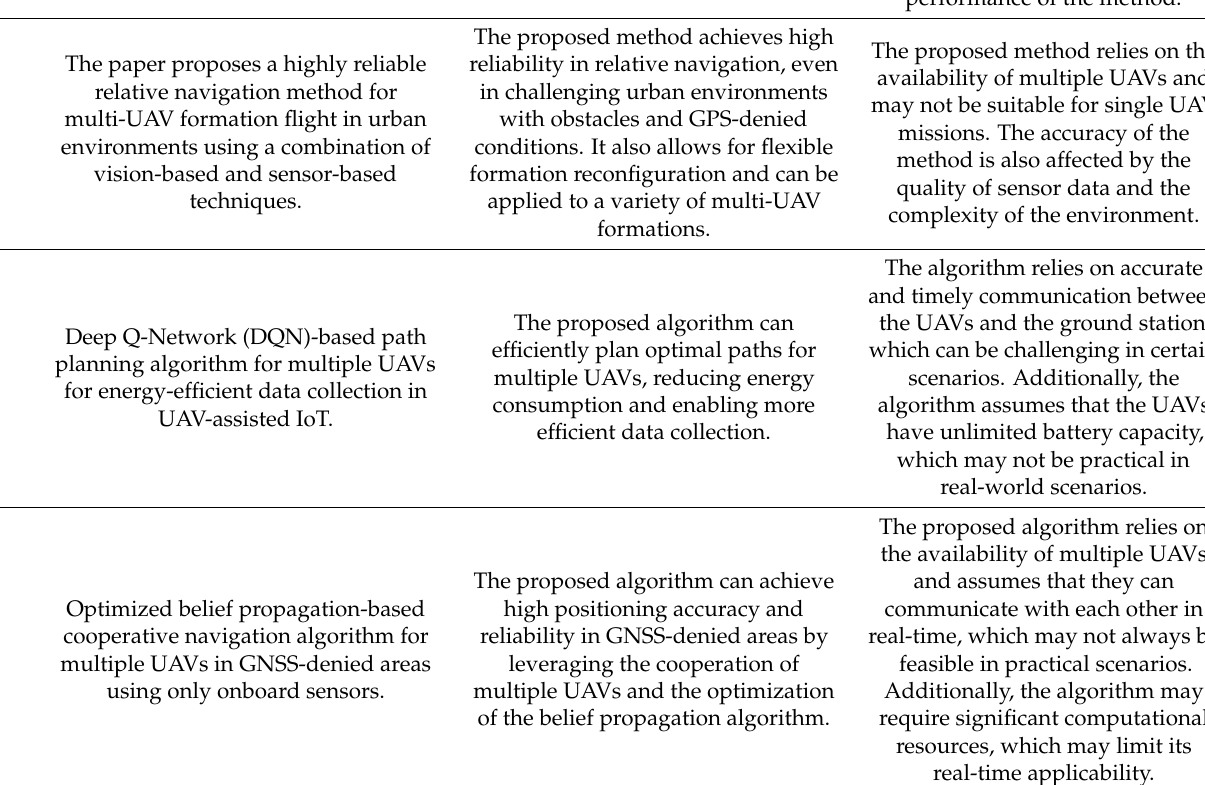
algorithm for UAV autonomous